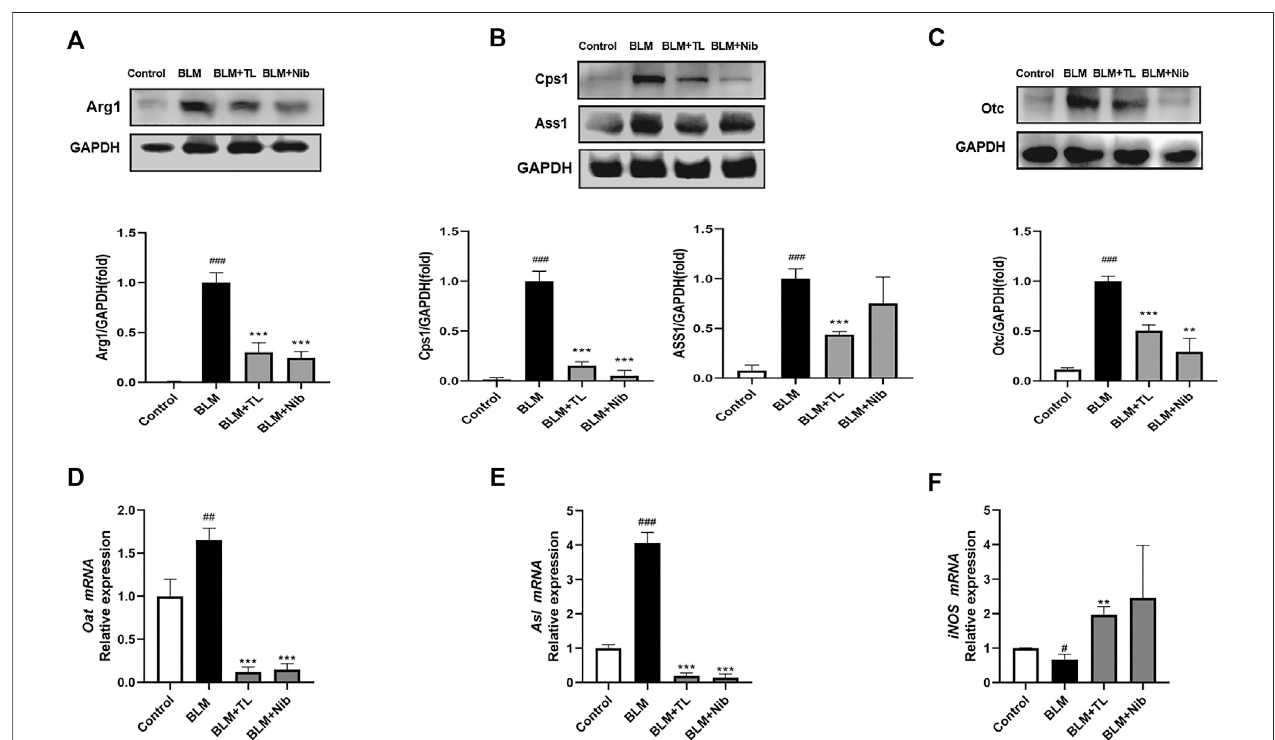
FIGURE 7 | TL inhibited BLM-induced arginase-ornithine pathway upregulation in vivo . 14 days after BLM (2.5 mg/kg) or 0.9% saline treatment, Control and BLM miceweretreatedwith0.9%saline;TLmiceweretreatedwith45 mg/kg/dayTL;Nibmiceweretreatedwith60 mg/kg/dayNib.RepresentativeWesternblottingimages and foldchangesinrelative densitometric valuesofArg 1,CPS1,ASS1,andOTC inlungtissuesfrommice( n (cid:2) 3) (A,B,C). RelativemRNAexpression of OAT,ASL,and iNOS in lung tissues were detected by real time-PCR analysis ( n (cid:2) 3) ( D, E, F ). Data were expressed as mean ± SEM, vs. the Control group, # p < 0.05, ## p < 0.01, #### p < 0.001, NS, non-signi fi cant; vs. the BLM group *p < 0.05, **p < 0.01, ***p < 0.001, NS, non-signi fi